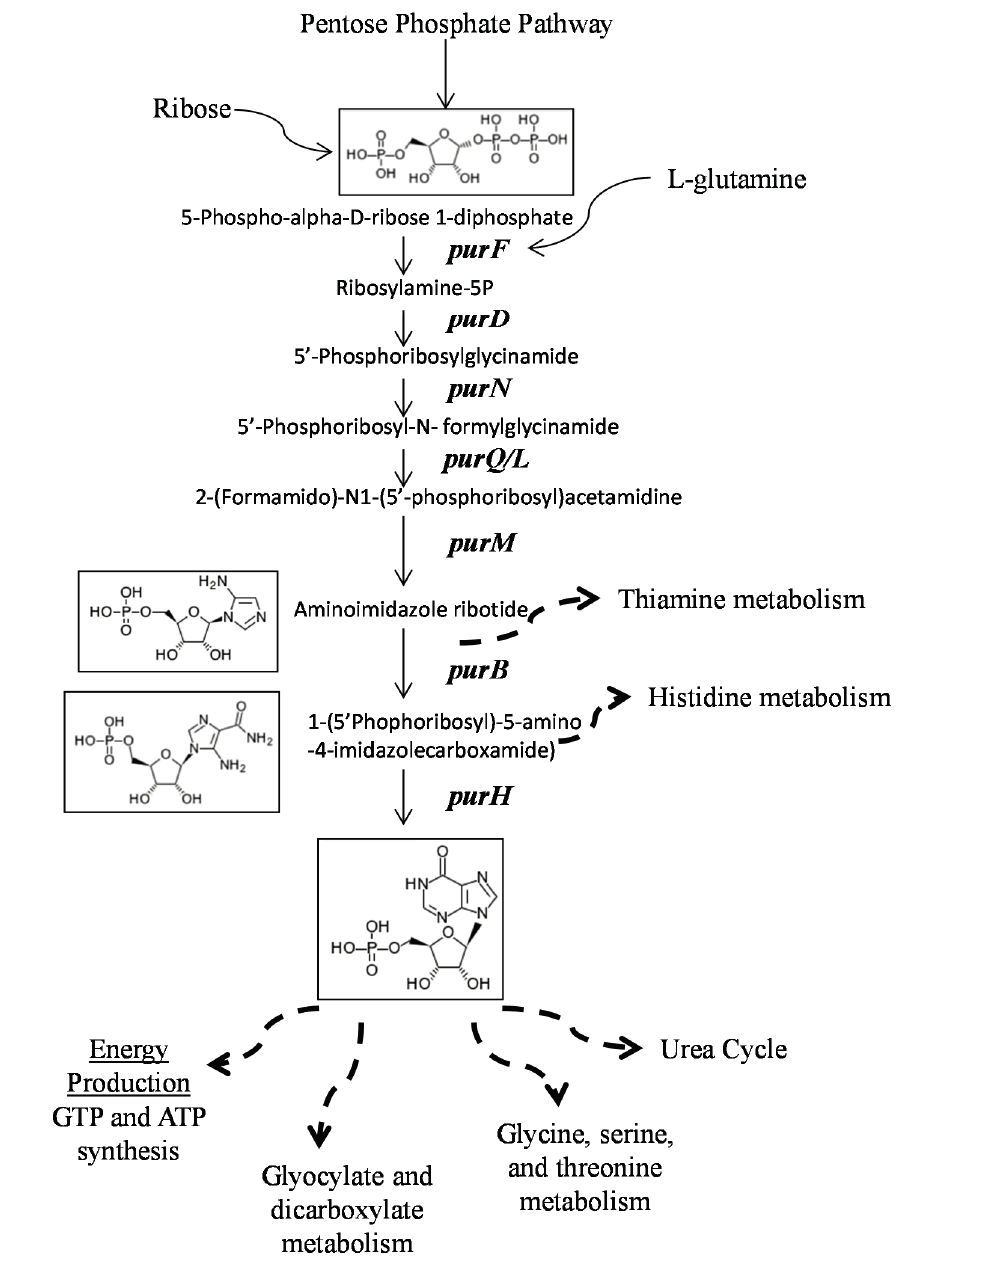
Figure 5. The schematic diagram of the pur pathway. The disruption of genes ( purB , F , H , M ) involved in the purine biosynthesis pathway may cause defects in downstream energy production, amino acid biosynthesis and urea cycle, which may be responsible for the defect in persistence observed in this study to rifampicin and other antibiotics and